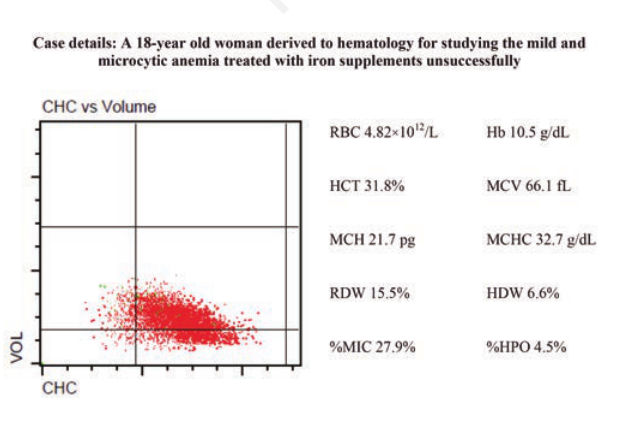
Figure 3. Iron deficiency anemia. In iron deficiency, the red cells are microcytic hypochromic and show significant poikilocytosis. Therefore the red cell cytogram shows the majority of the red cell population to be in the microcytic hypochromic zone, i.e. , a shift to the left and lower region of the cytogram. The corresponding change in the numerical parameters is anemia with low red cell indices and a raised red cells distribution width (RDW), which reflects the anisocytosis and polychromasia. Key features: anemia, low red cell indices, high RDW, and shift of the red blood cells cytogram to the left and lower (microcytic hypochromic) zone, with a spread fan shaped signals, corresponding with the variety of volumes and chromicity of the whole set of red Figure 4. b -thalassemia with concomitant iron deficiency. When iron deficiency and thalassemia coexist the typical patterns melt. Red cells are microcytic and tend to be more hypochromic as they are in iron deficiency; the anisocytosis and polichromasia are reflected on the more spread signals than the narrow shape char- acteristic of a genetic